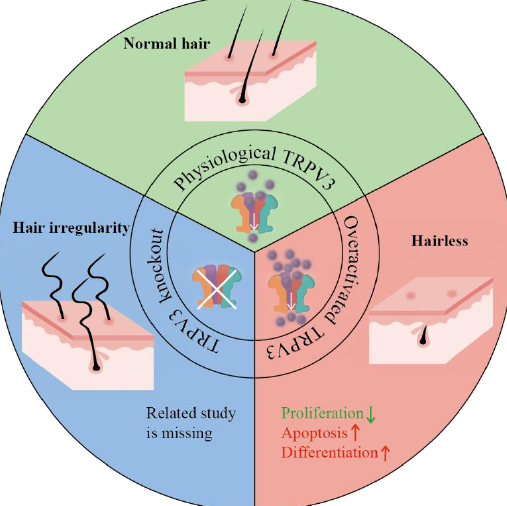
Figure 3. The regulatory effect of TRPV3 in hair development. Physiological TRPV3 maintains normal hair growth. Overactivated TRPV3 results in decreased proliferation, increased apoptosis, and increased differentiation of cells, as well as the hairless phenotype. TRPV3 knockout leads to hair irregularity.